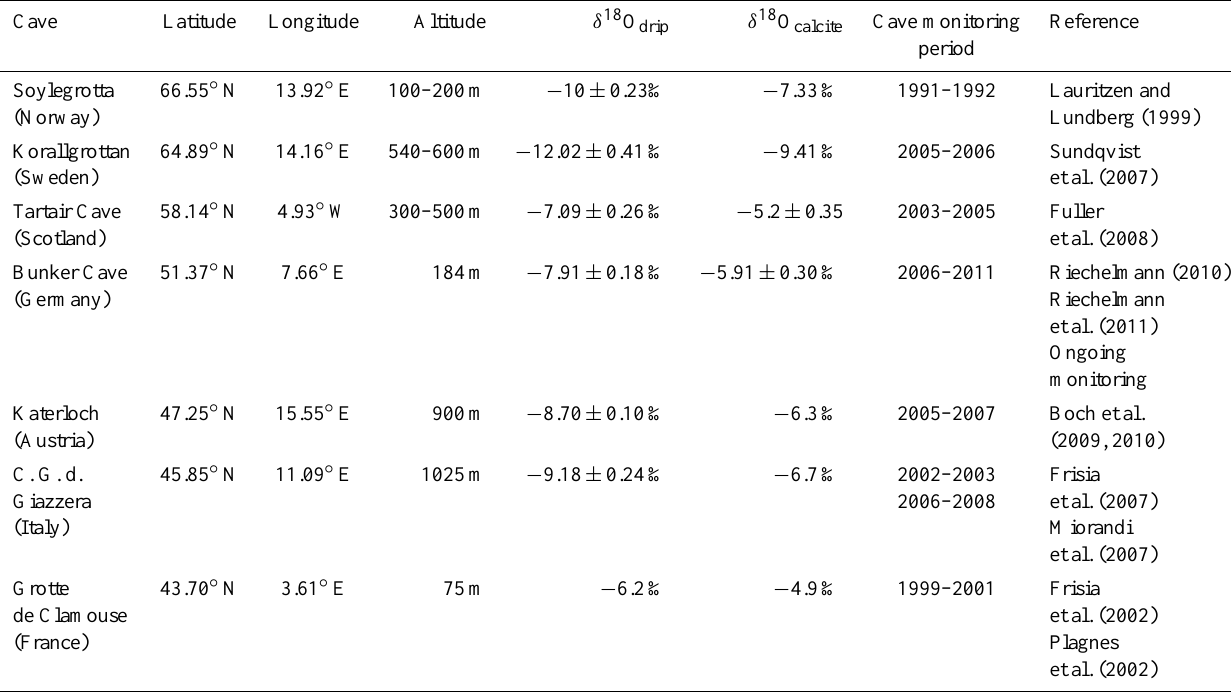
Table 1. Cave locations and compilation of isotope data from monitoring programs. Further information about the caves can be found in the respective references. Drip water δ 18 O values refer to VSMOW and calcite values to